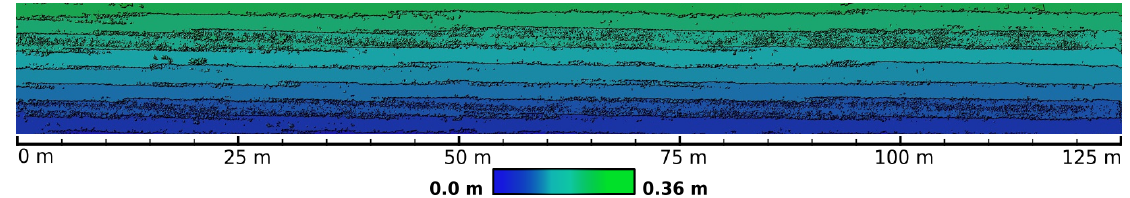
Figure 11. Digital elevation model map of the study parcel.